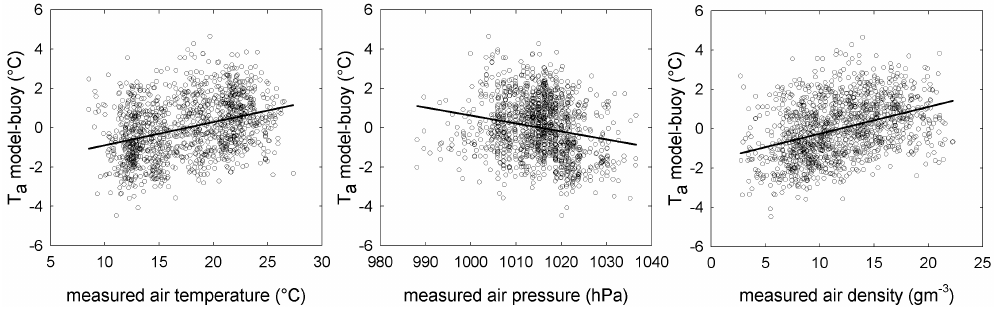
Fig. 9. Mean daily difference of air temperature ( T a ) between the basin average and the buoy’s measurements with respect to some surface parameters: barometric pressure, air temperature, and water vapour density,